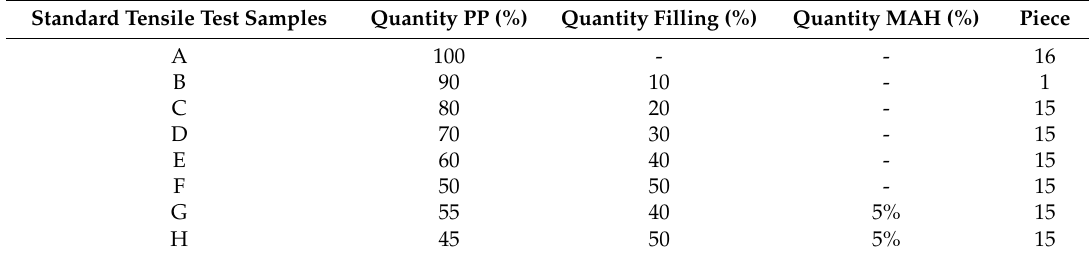
Table 2. The amounts and the quantities of filler by weight included in the polypropylene matrix specimens exposed to gamma radiation. MAH: maleic anhydride; PP: polypropylene. Standard Tensile Test